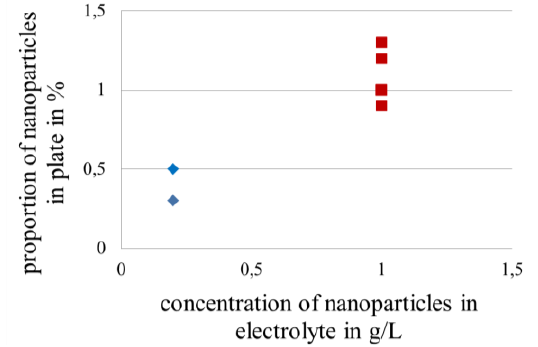
Figure 22. Correlation between the amount of nanoscale particles in layers and in